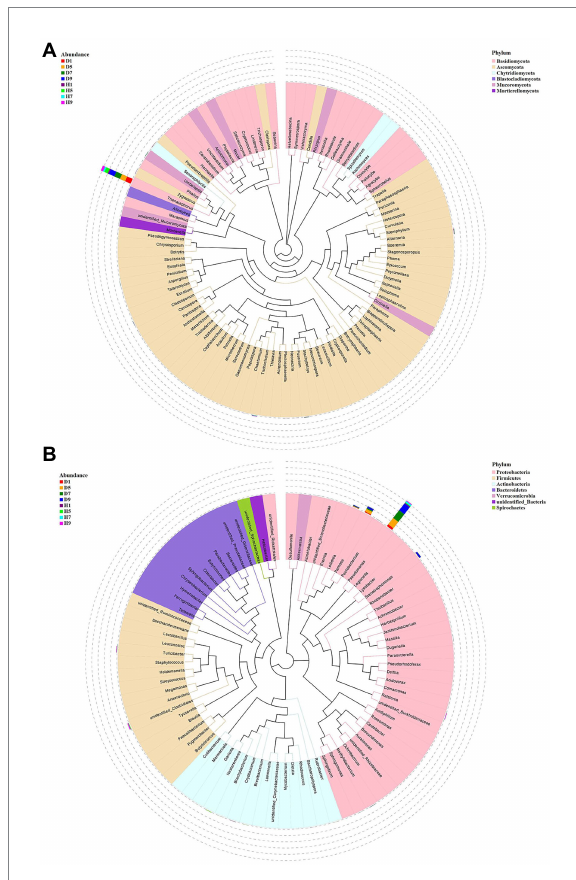
FIGURE 5 Maxium likelihood tree of the 100 most abundant fungal (A) and bacterial (B) genera in the eight group samples from tobacco target spot leaves. A color-coded bar plot shows the distribution of each fungal and bacterial genus in different